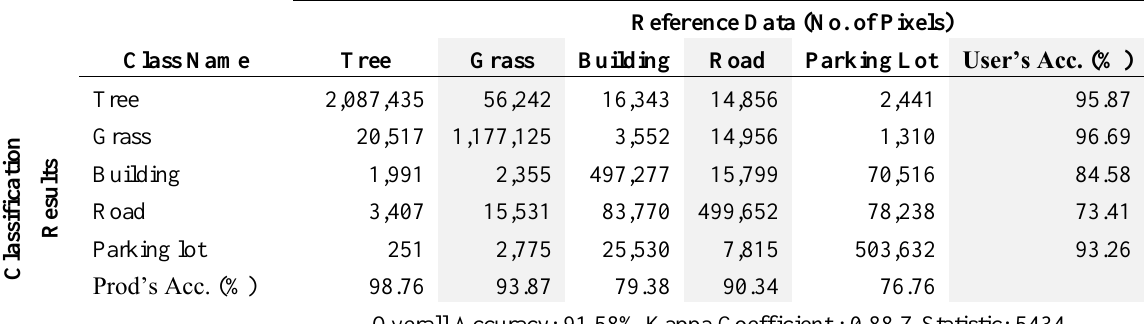
Table 4. Classification results for the QB Test image.